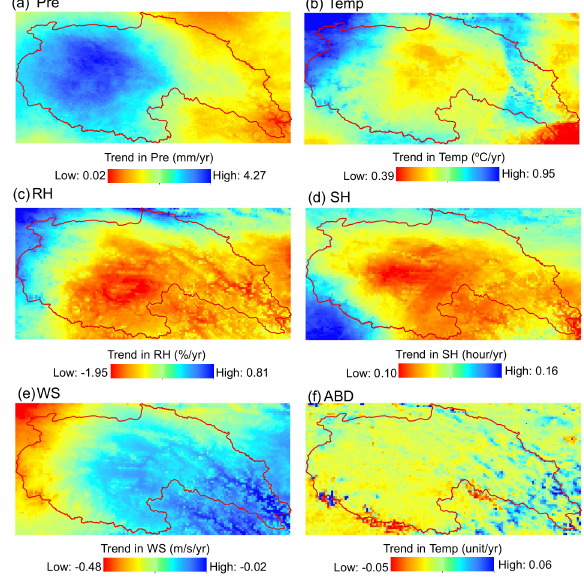
Figure 6. Spatial pattern of trends in climatic and vegetation characteristics in the study basin over the period 1981–2014. The abbreviations in the figure denote di ff erent environmental variables: Pre-precipitation, Temp-mean temperature, RH-relative humidity, SH-sunshine hour, WS-wind speed at 2 m above the ground, and